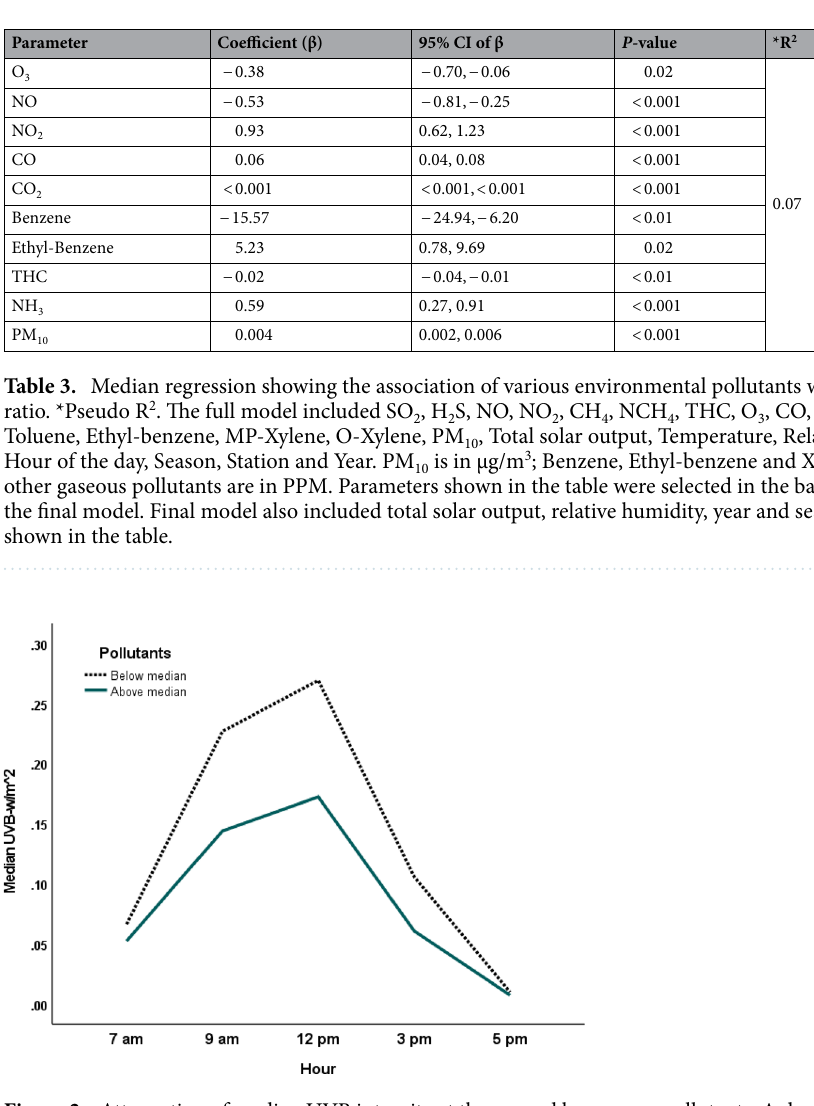
Figure 2. Attenuation of median UVB intensity at the ground by gaseous pollutants. A dummy variable was created by multiplying all the variables (included in Table 2) that were significantly associated with UVB (either positively or negatively). This dummy variable was then categorized into two groups (below median or above median) and median UVB was plotted for each group across different hours of the day. Dotted line represents UVB profile with pollutants level below the median and solid line represents UVB profile with pollutant level above the median. Repeated measure two-factor ANOVA showed that the two lines are significantly different ( p <